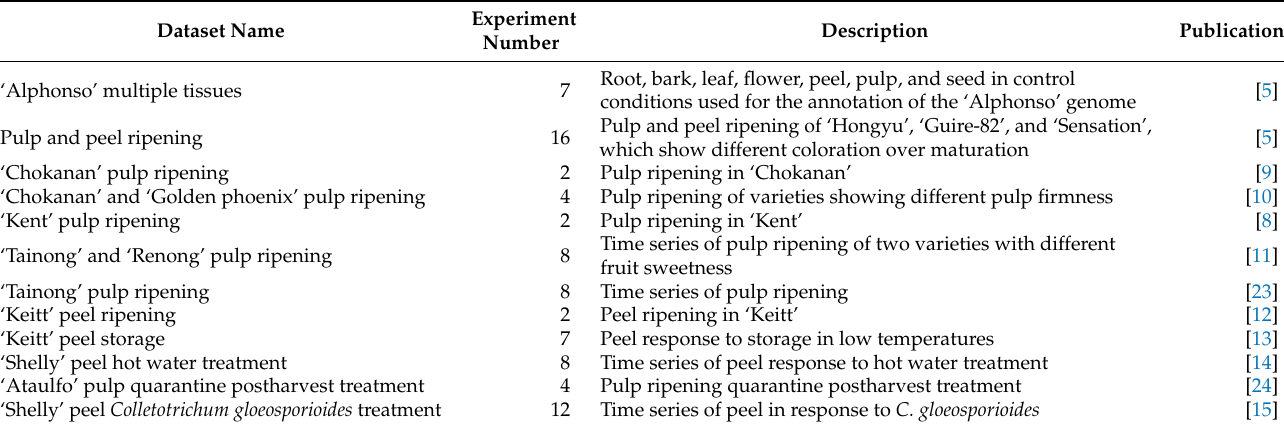
Table 1. Expression datasets available at